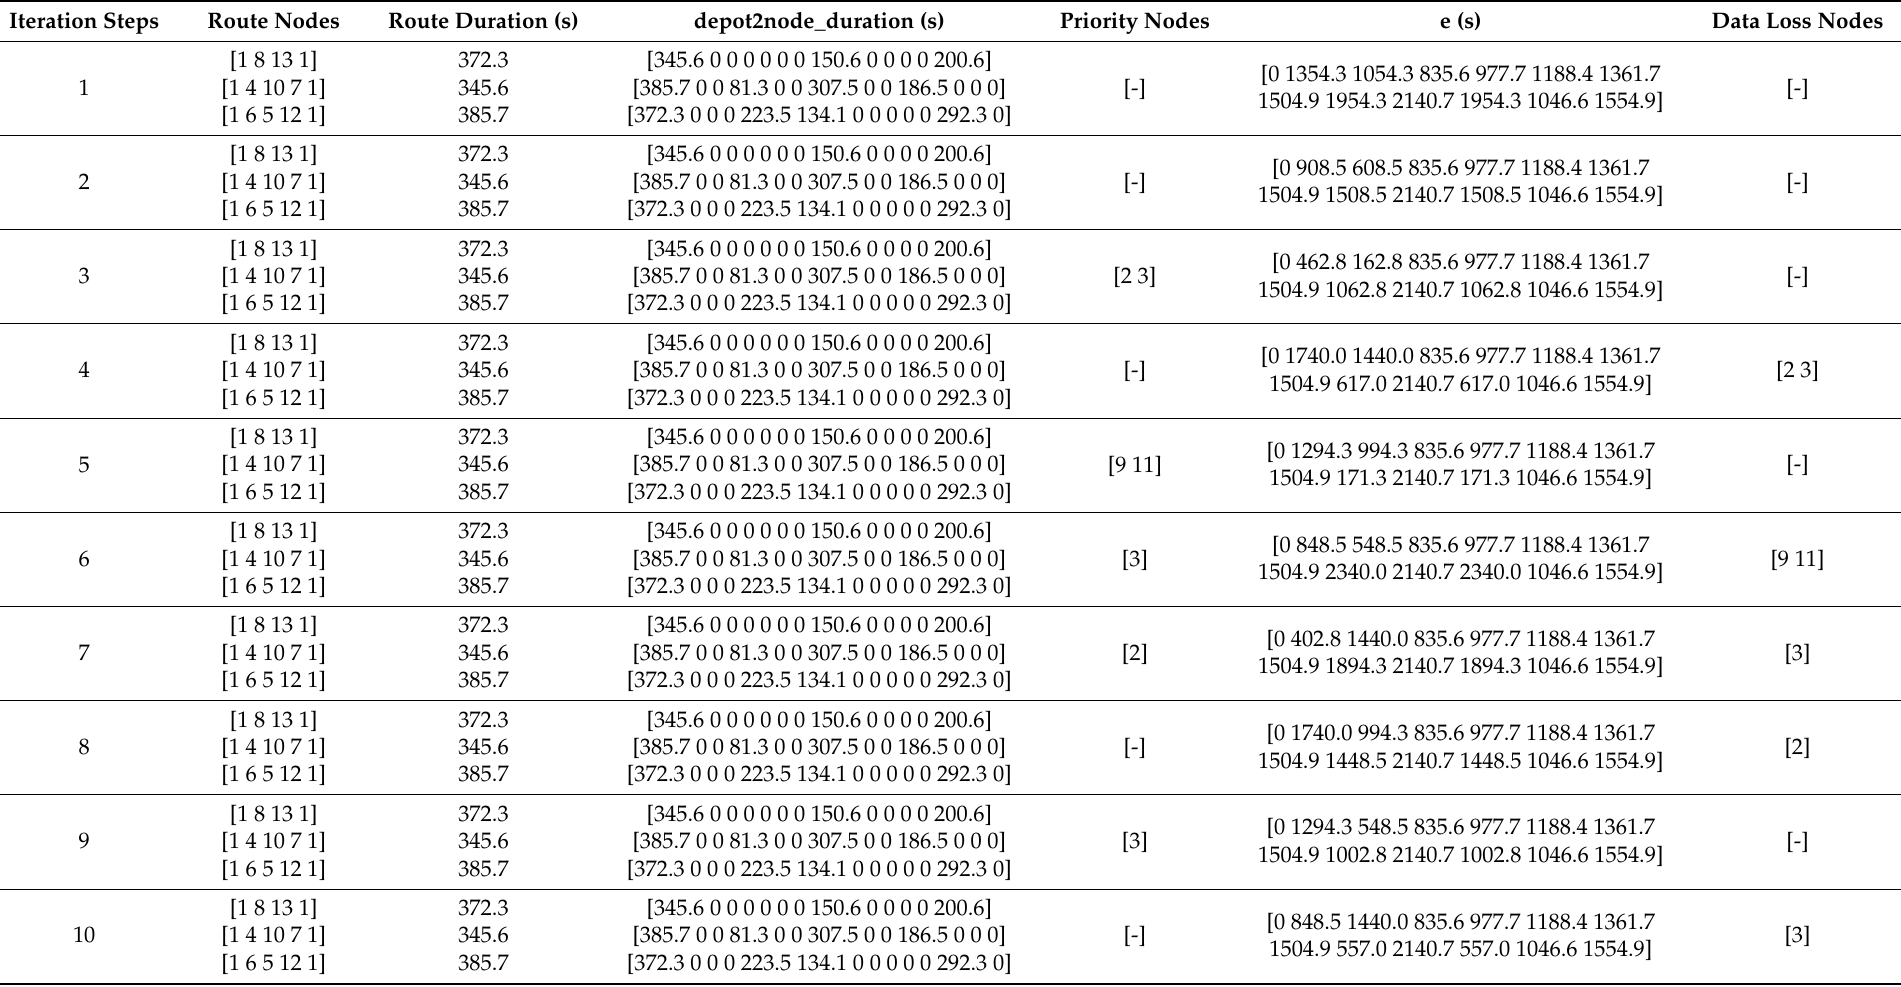
Table 4. MES Routes Results for 13 Nodes and 3 MoEls—No priorities